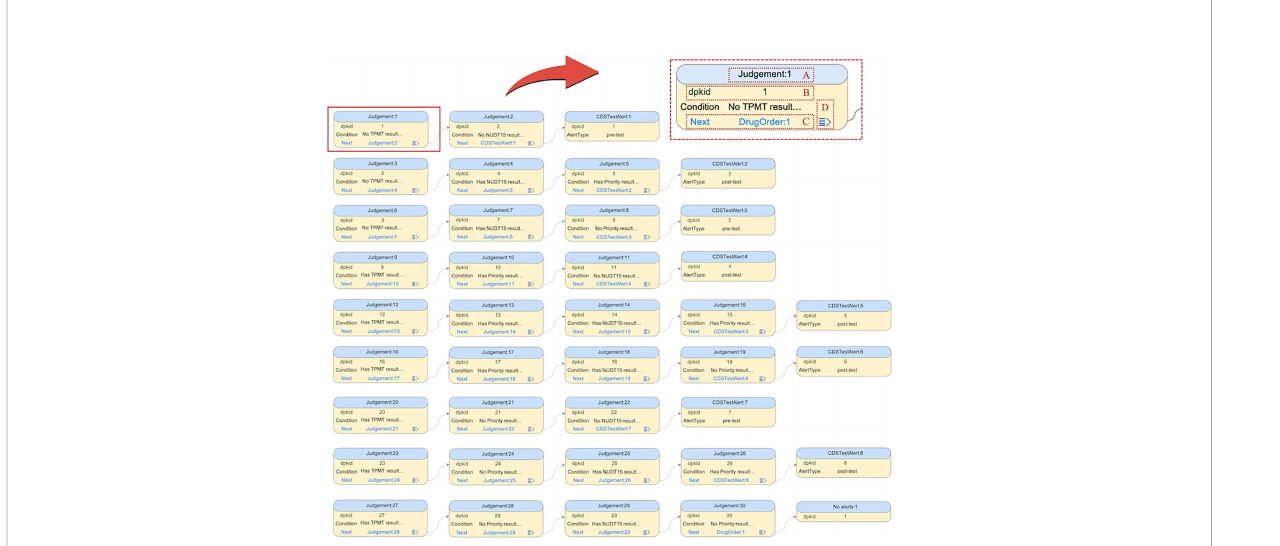
FIGURE 3 Interface of MMKP knowledge entry. Each cell frame represents a judgement or a decision in the decision fl ow. (A) Each frame is identi fi ed by its table name and primary key, which is quoted by the polymorphic foreign key. (B) Only tables with a single unique key can be linked by polymorphic foreign keys. The MMKP tool will automatically create a unique self-incrementing key for each table record, and this key is marked in green. (C) The value of the polymorphic foreign key is de fi nite and unique and is marked blue. Users can drag and drop to make connections between a polymorphic foreign key fi eld and a table record. (D) Users can choose to display or hide the downstream tables as necessary by expanding the